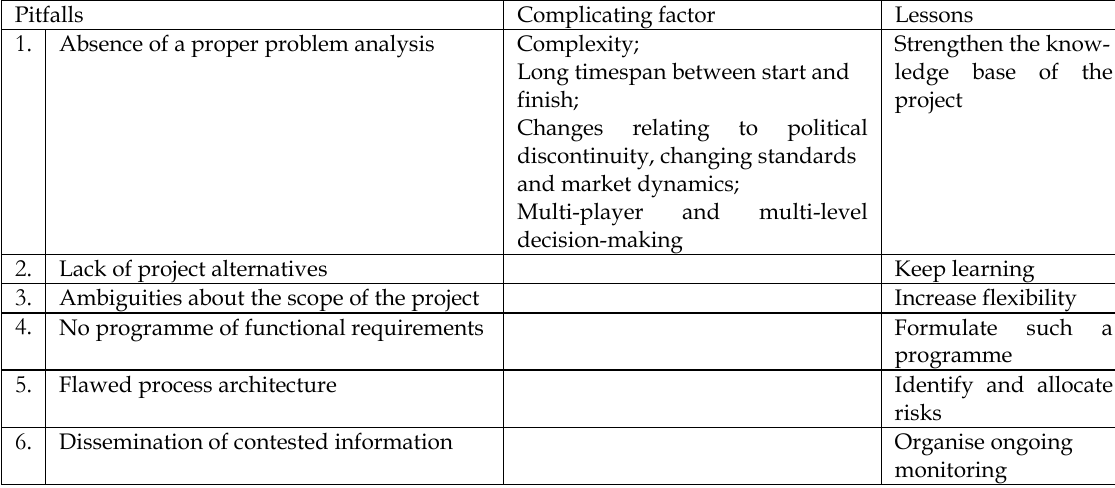
Table 1. Systematic specification of lessons learned